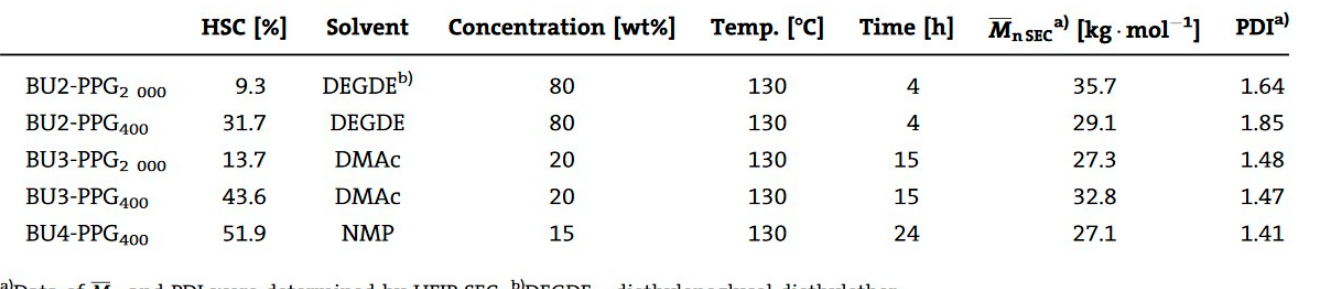
Figure 37. Table copied from reference [60]. Results of polymerizations of dicarbamates with PPGda. From reference [60].